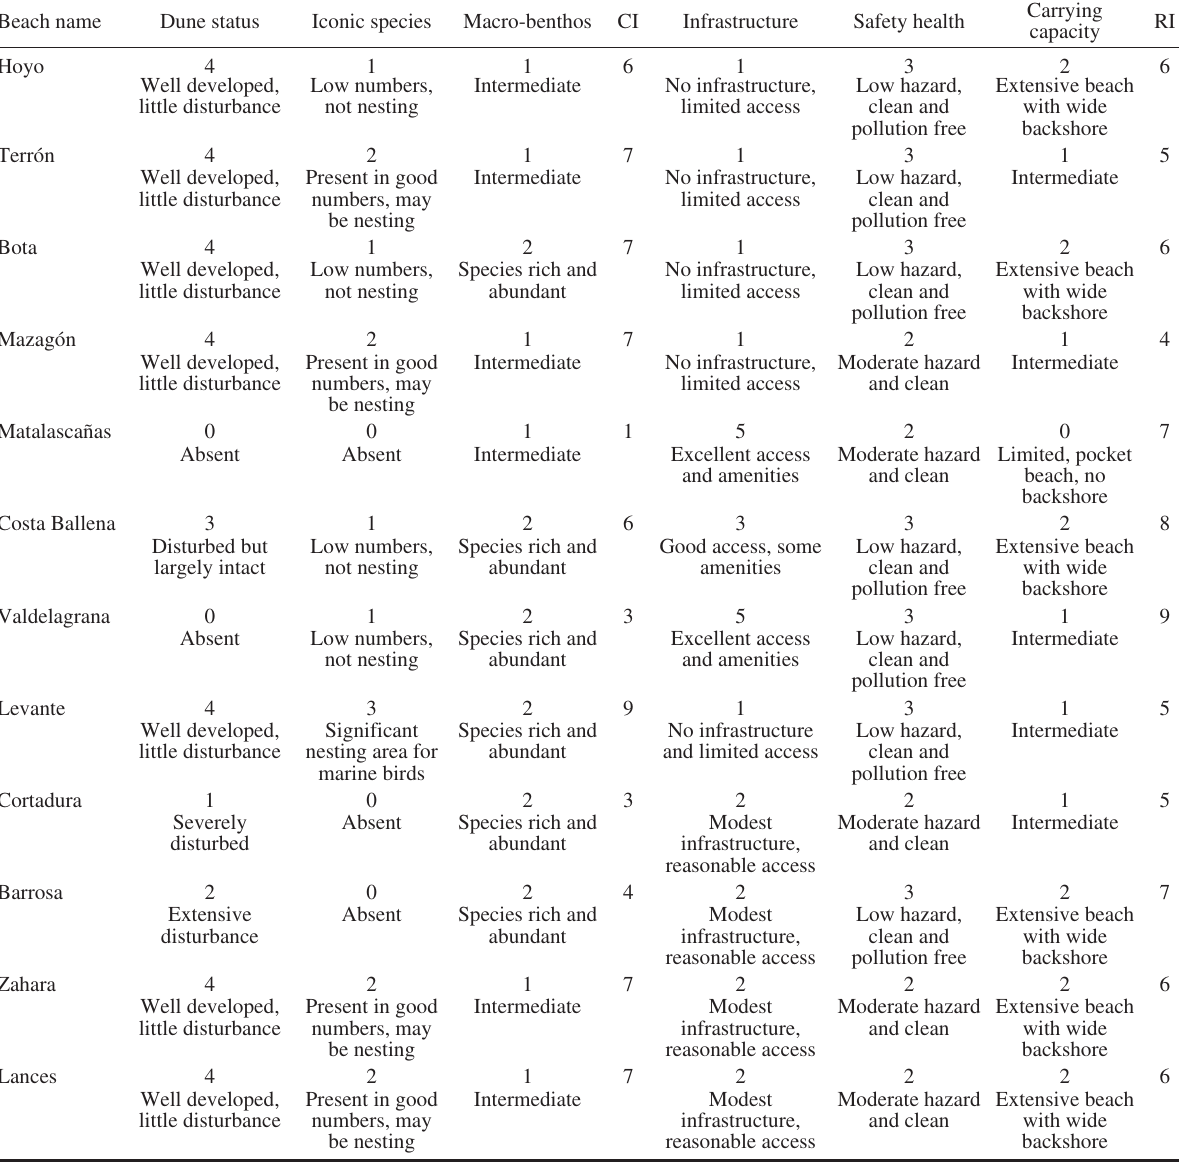
Table 2. – Conservation index (CI) and recreation potential index (RI) scores for beaches. Beach